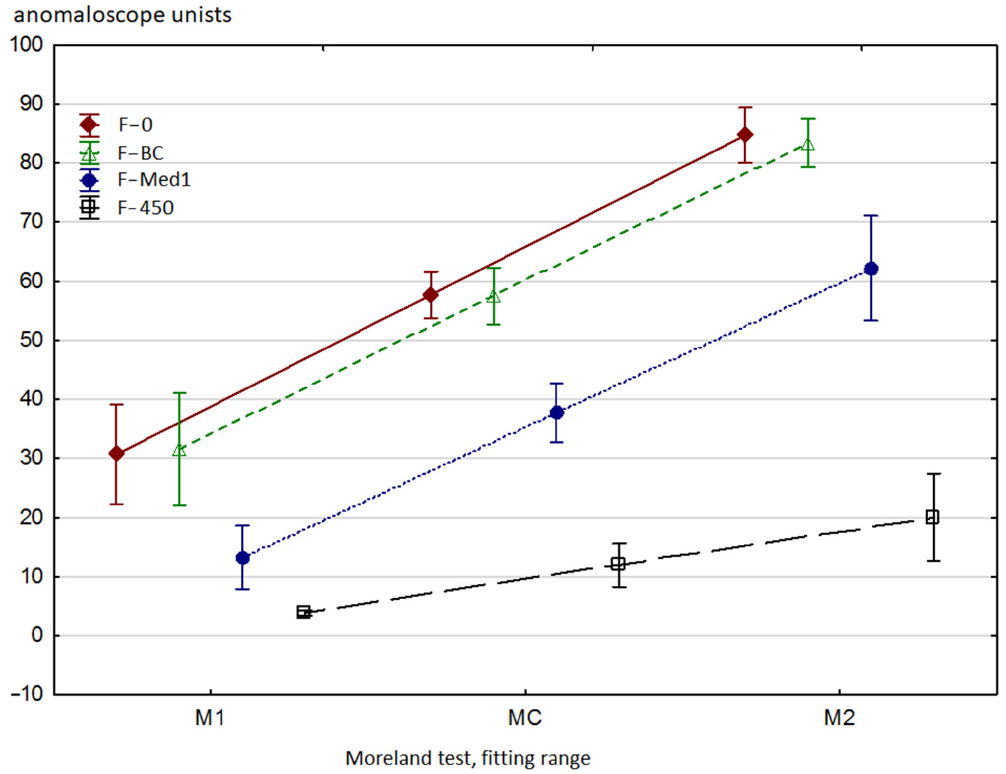
Figure 2. The results for M 1 , M C and M 2 in the Moreland test for each type of applied filters (mean/mean standard error). The anomaloscope units refer to the blue–green diode proportion in the test field: 0 au: 100% blue and 0% green; 100 au: 100% blue and 0% green. The Blue Control filter did not significantly affect the results due to its minimum absorption of blue light. Application of the F-Med1 filter significantly decreased M 1 and M 2 but did not considerably reduce the width of the matching range. The oscillation range of the M 1 variable was reduced but, conversely, the variability of M 2 increased. The use of the F-450 filter reduced M 1 and M 2 values to very low levels. Matching the test field color to the reference field color was possible only provided that a high intensity of blue diode light was set. Thus, the test results were as expected for patients with tritanopia. All the differences between the filter types were statistically significant for M 1 , M 2 and M C , except for the F-0 vs. F-BC comparison. Table 2. The results for the analyzed parameters (mean ± standard deviation) and statistical significance of the differences in the Wilcoxon test as compared to the results in the preceding columns; no—no significance, +— p < 0.05, *— p < 0.01, **— p < 0.001.